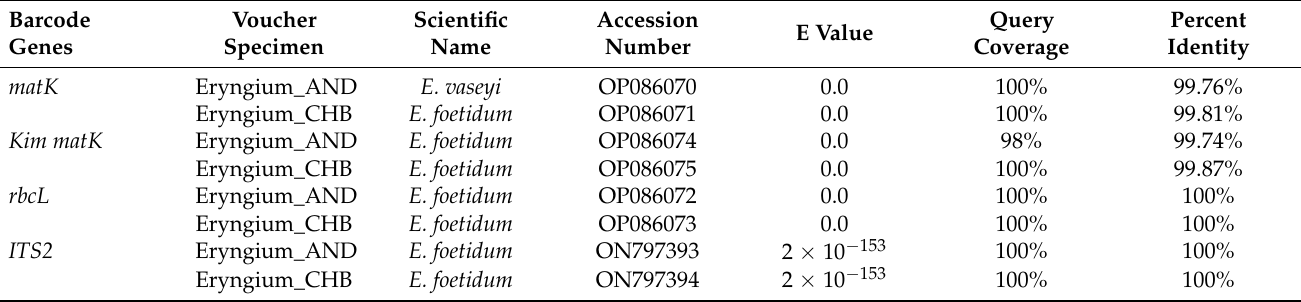
Table 2. Molecular identification of Eryngium sp. using matK , Kim matK , rbcL , and ITS2 barcode